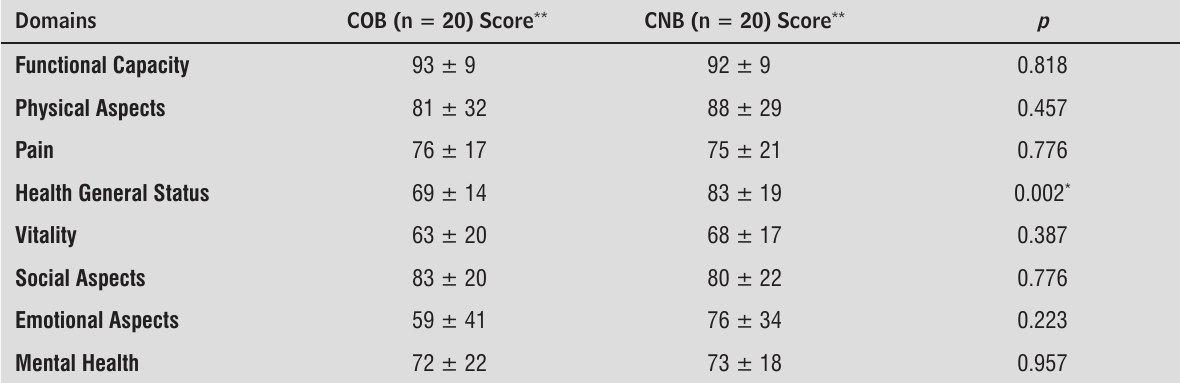
Table 3 - Comparison of the obtained scores for the eight domains of quality of life questionnaire between